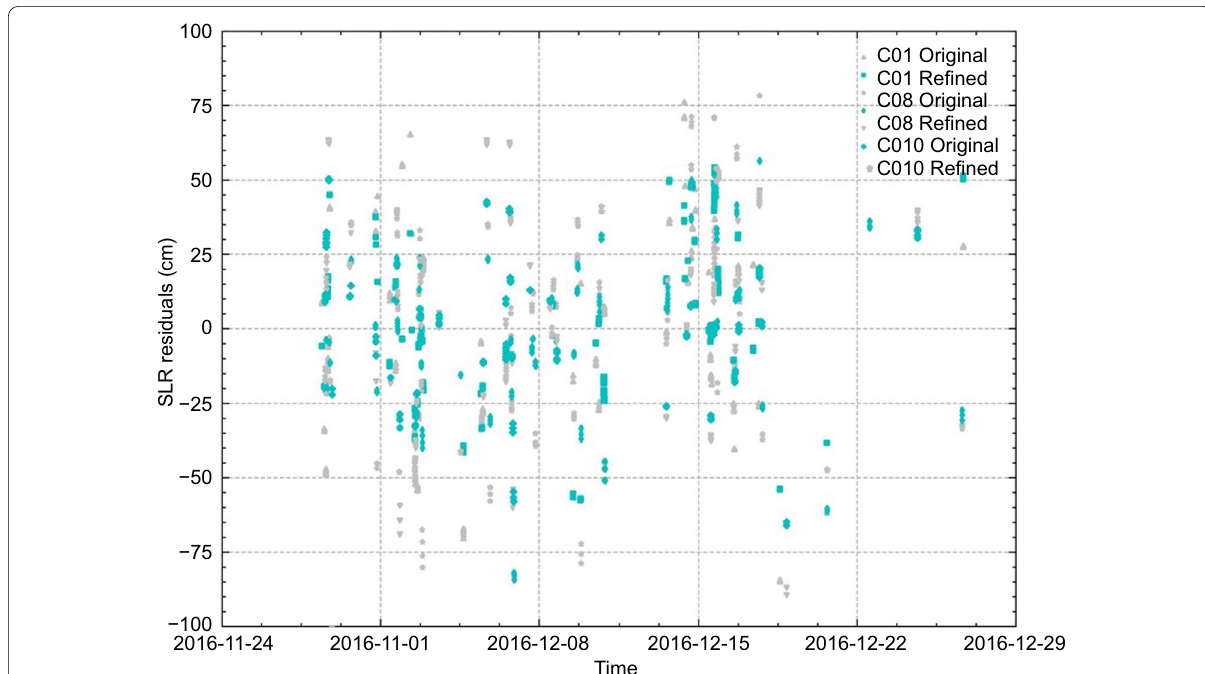
Fig. 7 SLR validation results of the original ODTS orbits and refined orbits during the period between Nov. 28, 2016, and Dec. 26, 2016, for C01 C08 and C10, where the light and deep color represents original and refined